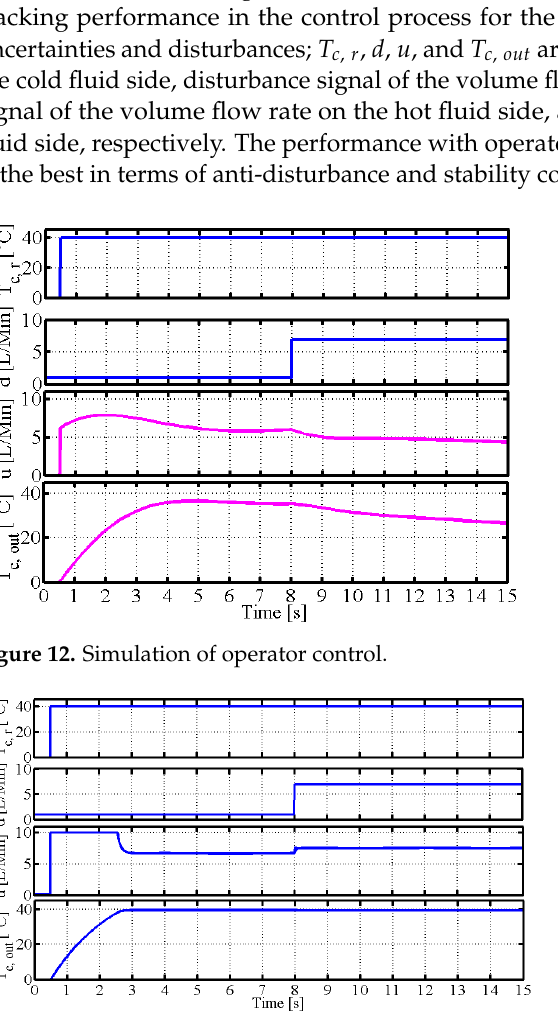
Figure 13. Simulation of FOPID with